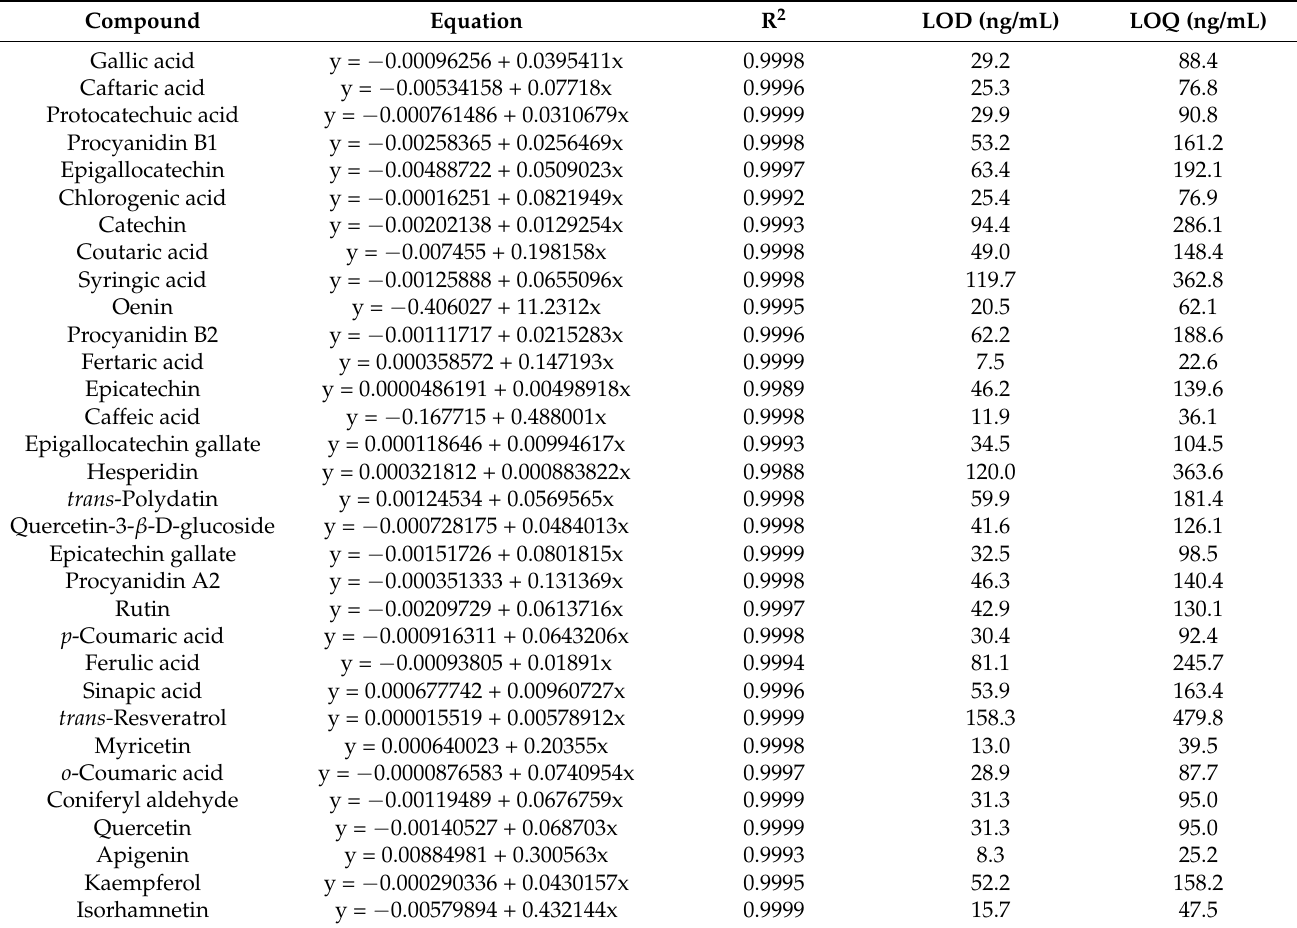
Table 2. Calculations of equations, correlation coefficients, LOD and LOQ for each phenolic